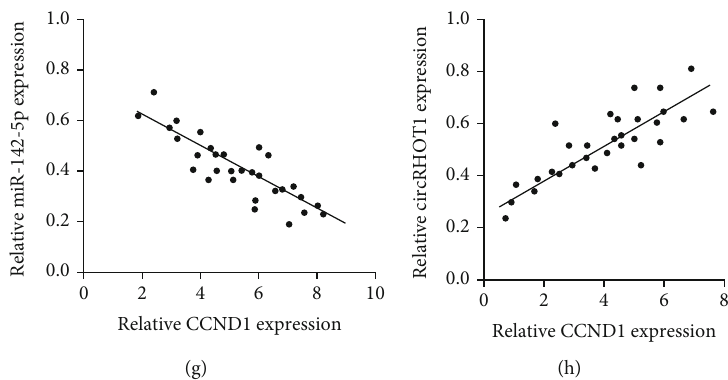
Figure 1: The expression of circRHOT1, miR-142-5p, CCND1, and autophagy markers in OA patients. (a, b) The expression of autophagy markers, including LC3 and beclin1, was measured by qPCR in clinical OA samples ( n = 30 ) and healthy cases ( n = 30 ). (c) The expression of circRHOT1 was detected by qPCR in clinical OA samples ( n = 30 ) and healthy cases ( n = 30 ). (d) The expression of CCND1 was determined by qPCR in clinical OA samples ( n = 30 ) and healthy cases ( n = 30 ). (e) The expression of miR-142-5p was analyzed by qPCR in clinical OA samples ( n = 30 ) and healthy cases ( n = 30 ). (f) – (h) The correlation of circRHOT1, miR-142-5p, and CCND1 was analyzed in clinical OA samples ( n = 30 ). Mean ± SD , ∗∗ P < 0 : 01